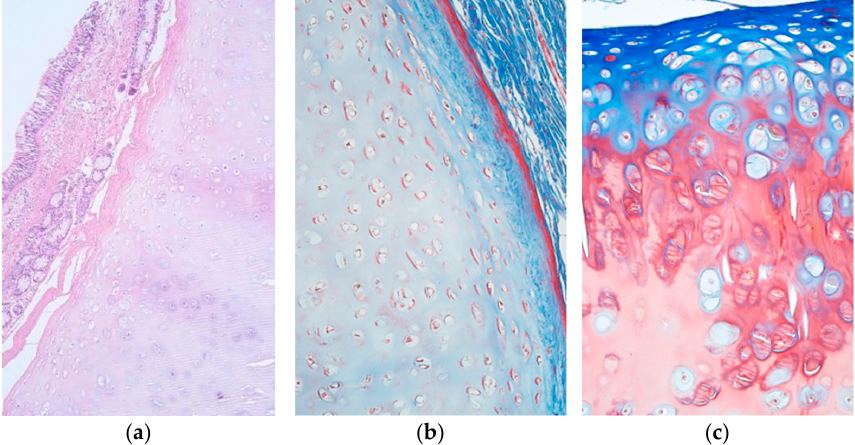
Figure 1. ( a – c ) Micrographs of tracheal structures in healthy subjects. ( a ) Unchanged tracheal wall containing pseudostratified ciliated epithelium, seromucous glands and tracheal hyaline cartilage. Haematoxylin and eosin, ×100. ( b ) Tracheal hyaline cartilage without signs of ossification. Masson’s trichrome, ×200. ( c ) Note the ossification of tracheal hyaline cartilage. Masson’s trichrome, ×200. numerous positive cells; +++—numerous positive cells in the visual field; +++/++++—numerous to abundant positive cells; ++++—abundant number of positive cells. Bismarck brown staining was positive in the extracellular matrix of proliferation and growth zones in all patient tissue samples; however, only 3 out of 27 were positive and 6 were partially positive in the mature cell zone. This staining also marked numerous positive cells in all of the cartilage zones (Tables 1 and 2, Figure 2a,b). Periodic acid–Schiff (PAS) staining was positive in the proliferation zone of 17 samples and 8 were also partially positive. Moreover, PAS stained 17 positive growth zones, while an additional 10 were partially positive. Lastly, almost all mature cell zones were positive, with the exception of two samples that were only partially positive. All of the tissue samples contained numerous PAS positive cells in proliferation, growth and mature cell zones (Tables 1 and 2, Figure 2c,d). Table 1. Distribution and appearance of extracellular matrix positives for Bismarck brown and PAS staining in healthy tracheal hyaline cartilage.